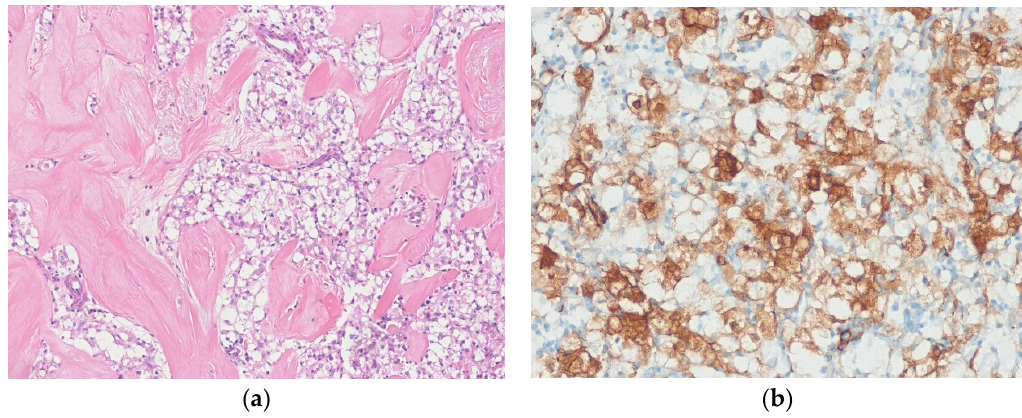
Figure 12. Sclerosing PEComa. ( a ) The tumor shows nests of epithelioid tumor cells with abundant clear cytoplasm. The densely hyalinized collagenous stroma is present. ( b ) The tumor cells are positive for SMA (H&E stain, original magnification 100× a ; SMA immunostain, original magnification 200× b